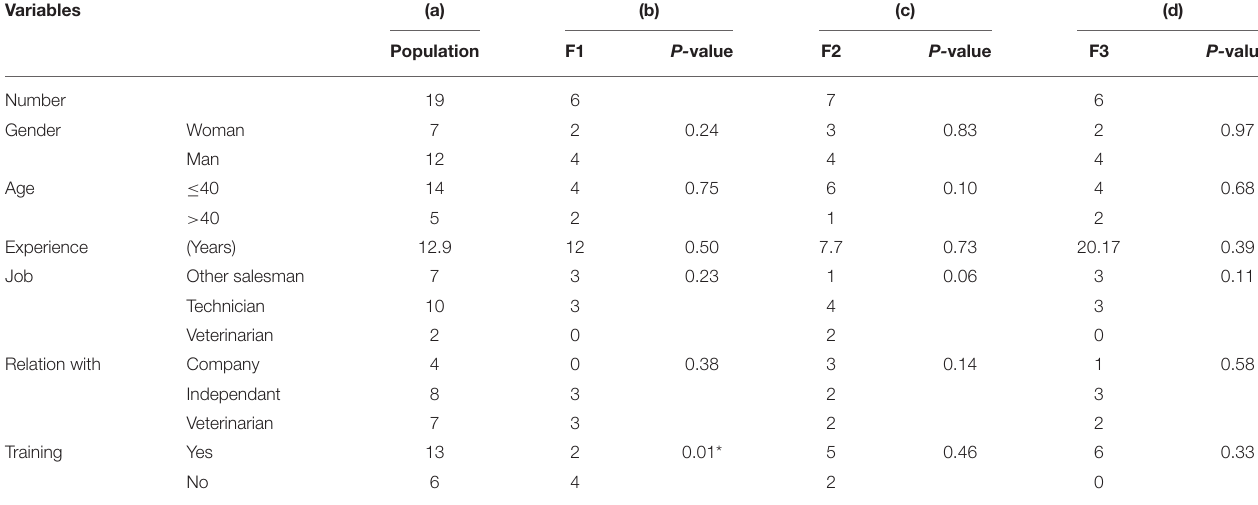
TABLE 3 | Socio-demographic variables and result of Kruskal-Wallis test for the whole population of drug vendors (a), people belonging to F1 (b), F2 (c), and F3 (d).